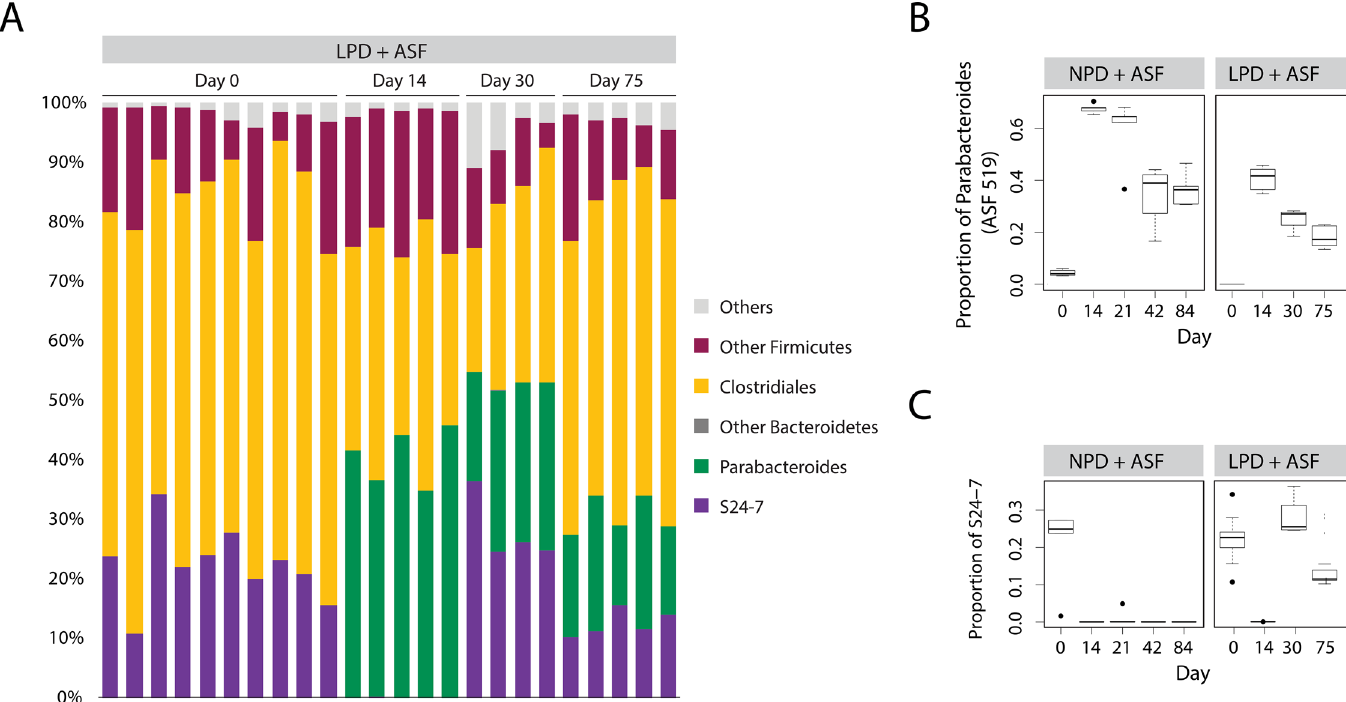
Fig 4. S24-7 returns after ASF transplantation into mice on a LPD but not on a NPD. (A) Relative abundance of bacterial taxa are shown. Each column represents a single sample of a pre-treated, ASF-transplanted mice on the LPD (LPD + ASF). Progression of inoculation is shown across multiple days post inoculation with ASF. Relative abundance of (B) Parabacteroides (including ASF 519) and (C) S24-7. Box and whiskers show the interquartile range; black circles mark the outlier